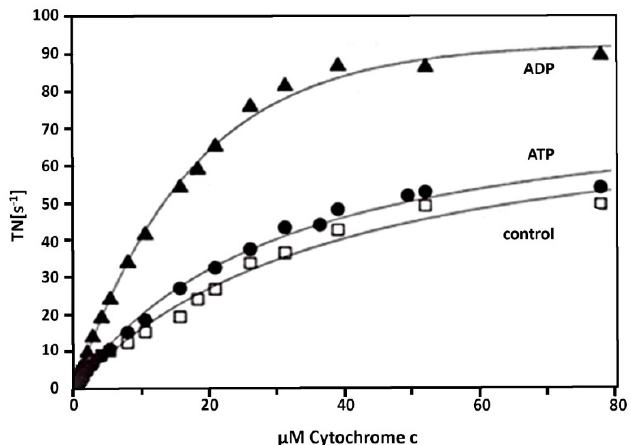
Figure 3. Activity of isolated cholate-CytOx from bovine heart in the presence of ADP, ATP, or without nucleotides after incubation of 0.1 µ M CytOx for 24 h at 0 ◦ C in 50 mM potassium phosphate (pH 7.4), 1 mM EDTA and 1% Tween 20 in the presence of 5 mM ATP ( ● ), 5 mM ADP ( ▲ ) or in the absence of nucleotides (control □ ). Oxygen uptake was measured at increasing cytochrome c concentrations. TN = turnover number (mole O 2 × s − 1 / mole heme aa 3 ). Note the resemblance in the course of activity between control vs. ATP bound to cholate-CytOx.